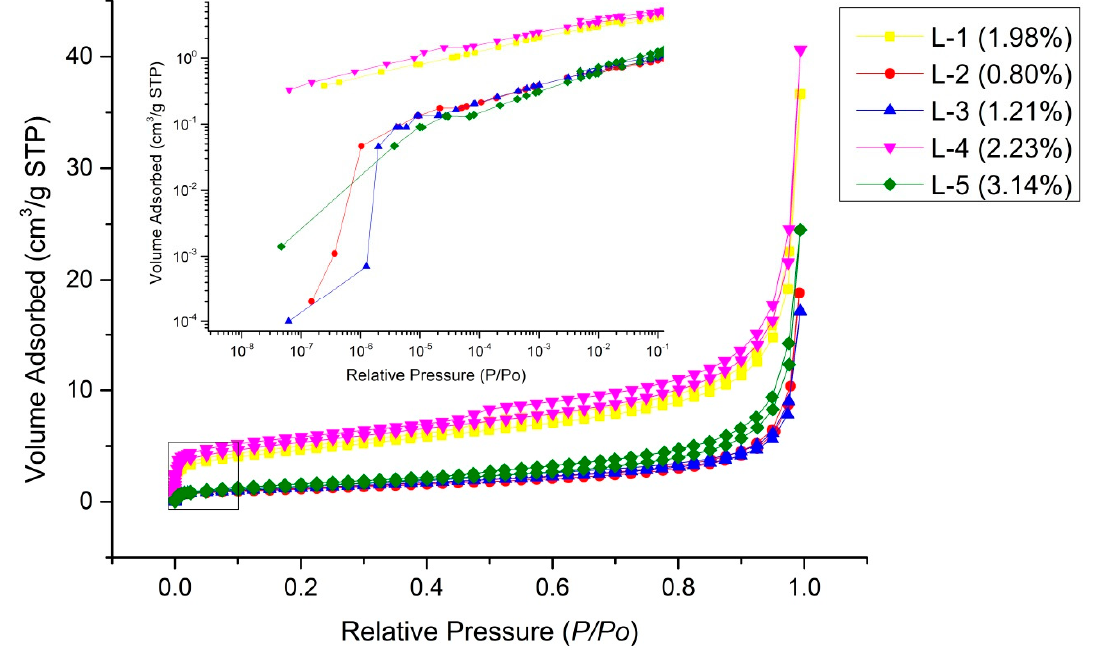
Figure 3. Low-pressure N 2 adsorption isotherms of samples, and a partial enlargement of their low relative pressure section (the area enclosed by a box). P and P o means equilibrium pressure and gas saturation pressure, respectively. Notice that the logarithmic X -axis was used to characterize the di ff erences more clearly between each